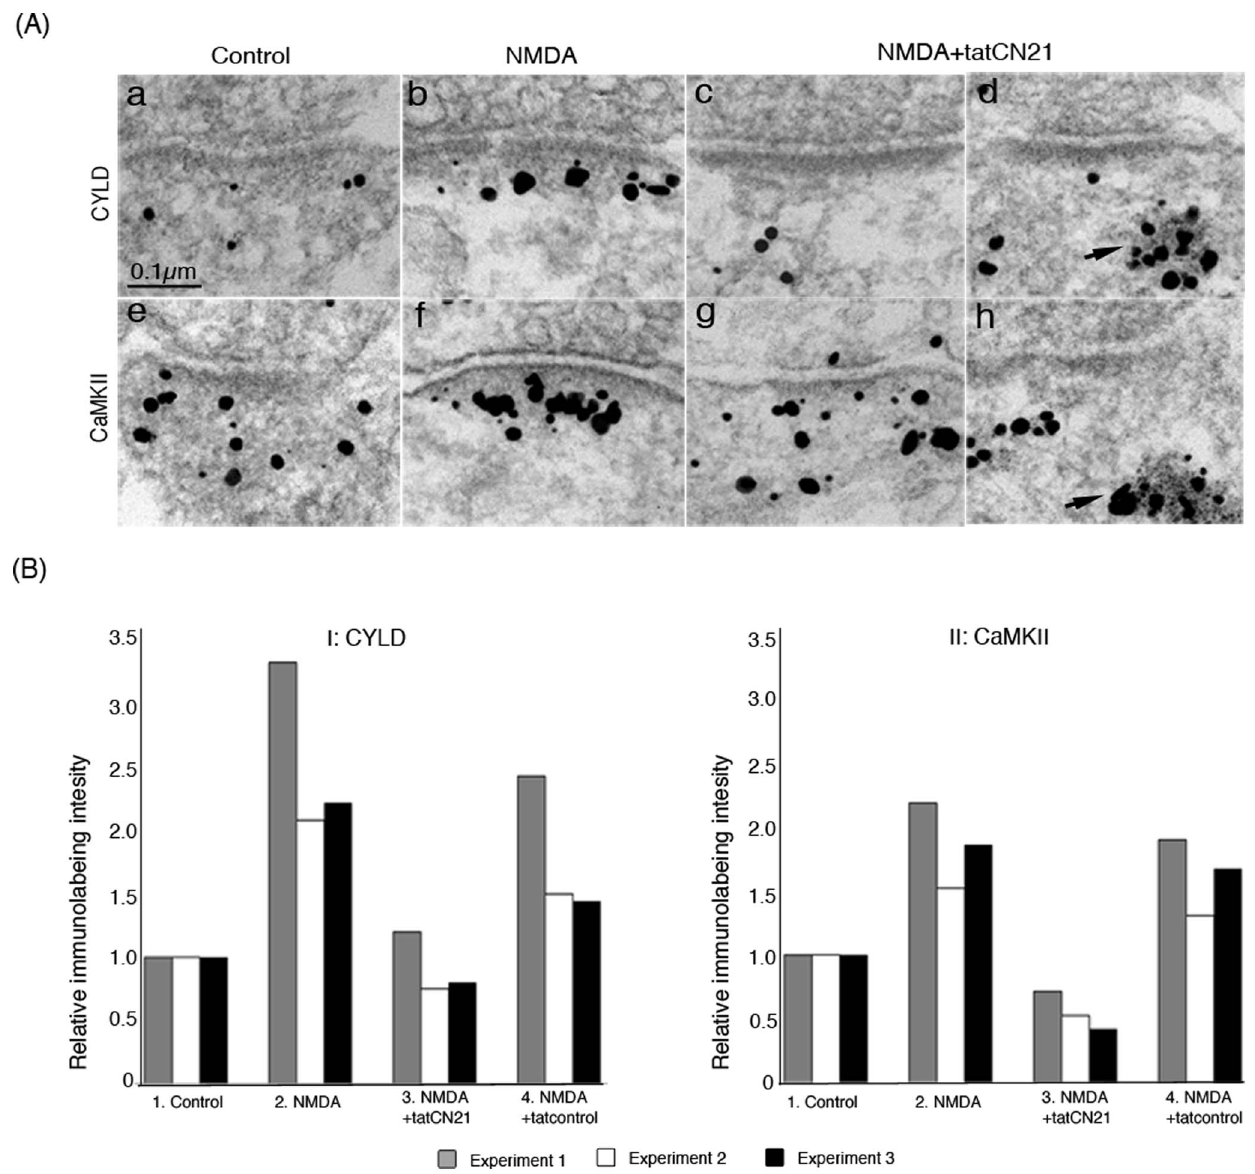
Figure 1. Recruitment of CYLD to the PSD is dependent on translocation of CaMKII to the PSD. Hippocampal cultures were pre- incubated for 20 min with or without the CaMKII inhibitor tatCN21 followed by the application of NMDA for 2 min. Parallel controls were incubated in medium alone. ( A ) Electron micrographs depicting immunogold labeling (dark grains of heterogeneous sizes) for CYLD (upper panel) or CaMKII (lower panel) at the synaptic region. Both CYLD (b) and CaMKII (f) accumulate at the PSD upon NMDA-treatment. Addition of tatCN21 blocks the NMDA-induced accumulation of both CYLD and CaMKII at the PSD. TatCN21-induced CaMKII-polyribosome aggregates (arrow in h) also label for CYLD (arrow in d). ( B ) Measurements of immunolabeling intensity for CYLD (I) and CaMKII (II) at the PSD in response to different treatments. Data were collected from three experiments, where sister cultures were labeled in parallel for CYLD and CaMKII. Mean immunolabeling intensities at the PSD (number of gold particles per unit length of PSD) were normalized with respect to the control group. Statistical analysis was carried out with one- way ANOVA followed by Tukey-posthoc test for individual experiments with significance level set at P , 0.05. For CYLD (BI): 1 vs. 2, significant in all three experiments; 2 vs. 3, significant in all three experiments; 1 vs. 3, not significant in all three experiments, 2 vs. 4, not significant in two out of three experiments; 3 vs. 4, significant two out of three experiments. For CaMKII (BII): 1 vs. 2, significant in all three experiments; 2 vs. 3, significant in all three experiments; 1 vs. 3, significant in two out of three experiments; 2 vs. 4, not significant in all three experiments; 3 vs. 4, significant in all three experiments. doi:10.1371/journal.pone.0091312.g001 (tatcontrol), on the other hand, was much smaller, reducing Additionally, tatCN21 at 20 m M induced formation of CaM- labeling intensities for CaMKII and CYLD to 88% and 70% KII-polyribosome aggregates in neuronal cultures. TatCN21- respectively. These results indicate that inhibition of CaMKII induced CaMKII-polyribosome aggregates often appeared near translocation via tatCN21 blocks CYLD translocation as well. synapses (Fig. 1 A h). Under the same conditions, these morphologically recognizable aggregates also labeled for CYLD